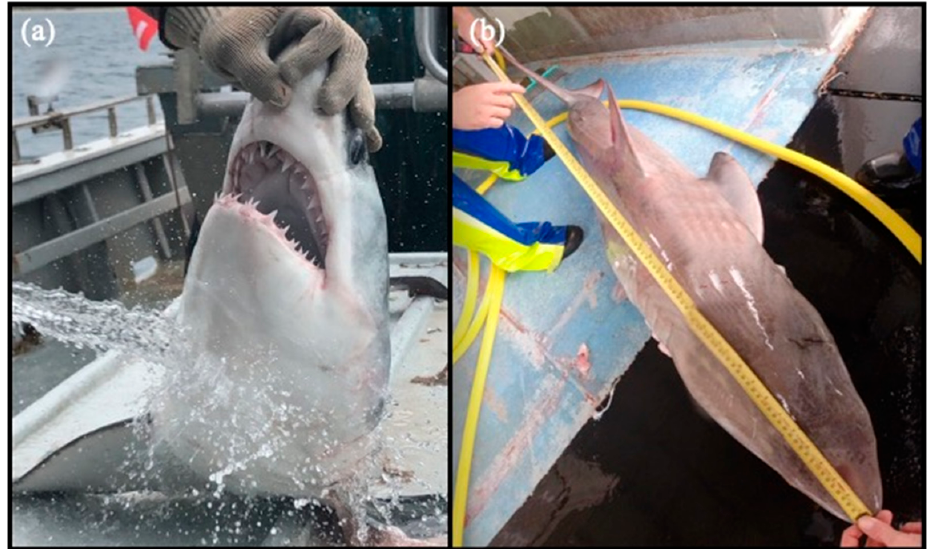
Figure 4. Examples of white shark ( Carcharodon carcharias ) bycatch associated with a commercial fishery operation at a site near Cocklebiddy, Western Australia; 32°16 ′ S, 126°17 ′ E). ( a ) A 1.40 m total length (TL) C. carcharias female captured in 2020. ( b ) A 1.70 m TL C. carcharias female captured in 2020.